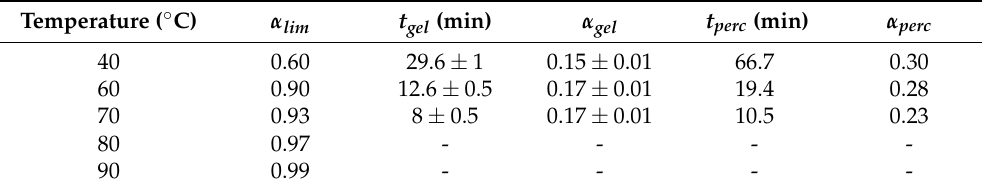
Table 2. Limiting conversion ( α lim ), percolation time ( t perc ) , and epoxy conversion at percolation ( α perc ) at different curing